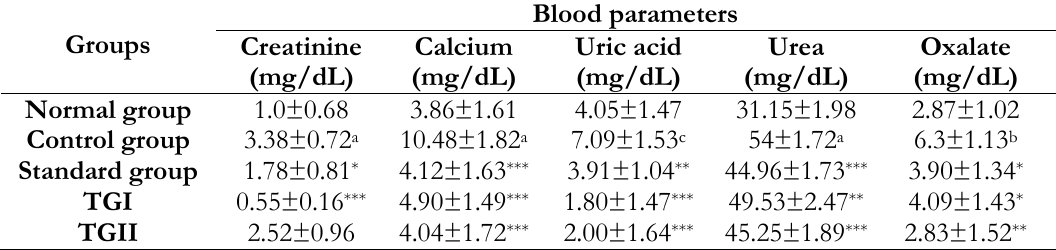
Figure 3. Histopathology of kidneys in various treatment groups. Animals had regular diet, B) Animals had regular diet + Supplemented with 0.75% EG and 2% AC in distilled water, C) Animals administered with CST (5mL/kg BW), D) TGI Animals administered with EETT 200mg/kg BW, E) TGI Animals administered with 400mg/kg BW. Table II. Effect of EETT on blood parameters in urolithiatic